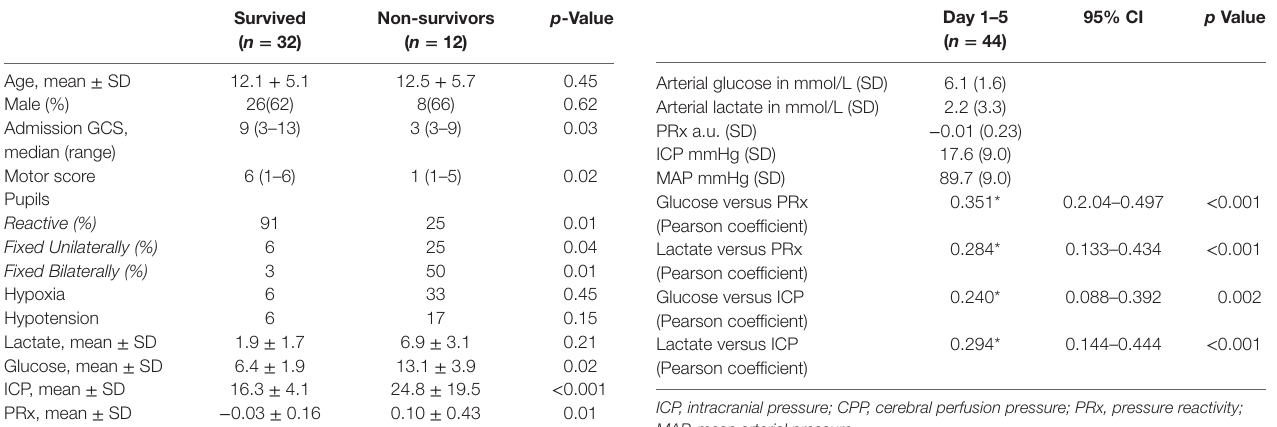
TaBle 2 | Mean values (SD) and correlations of physiologic variables during intracranial monitoring during the first 5 days since